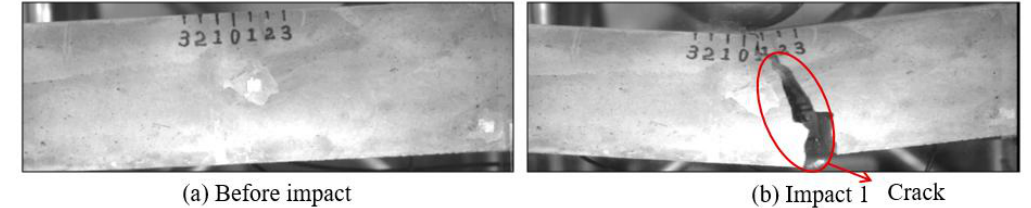
Figure 19 . Results of crack detection of Mortar-1 with high-speed video.